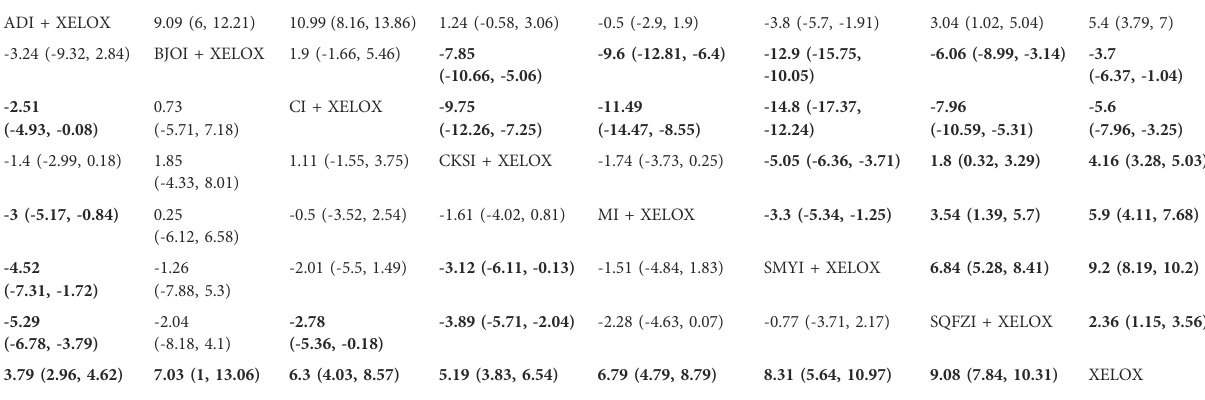
The values in bold are values with statistical analysis signi fi cance.